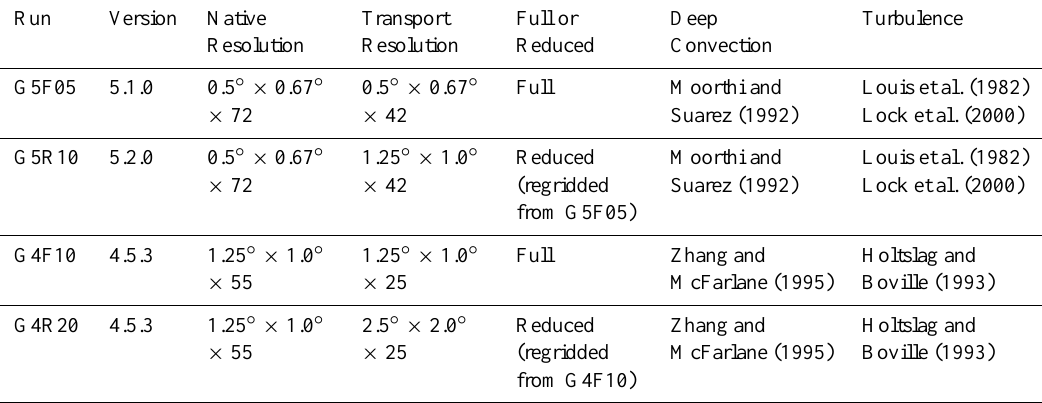
Table 1. Description of meteorological datasets used in offline tracer transport simulations. Column 1 (Data) is the code name for the meteorological dataset, 2 (Version) is the version of the analysis product, 3 (Native Resolution) is the resolution at which the analysis system (forecast + assimilation) is run ( a × b × c = latitude spacing × longitude spacing × number of vertical levels), 4 (Transport Resolution) is the grid spacing at which the analysis is saved, 5 (Full or Reduced) refers to whether the analysis is saved at the native resolution of the parent GCM or interpolated to a coarser resolution, 6 (Deep Convection) is the deep convection scheme of the parent GCM, and 7 (Turbulence) is the PBL turbulence scheme of the parent GCM. Naming convention for analysis product in the first column is as follows: character 1–2 is the product version number (G4 = GEOS-4 and G5 = GEOS-5), character 3 is the grid at which the analysis is saved (F = full resolution and R = reduced resolution), and character 4–5 is the latitude grid spacing at which the analysis is saved for offline transport (05 = 0.5 ◦ , 10 = 1.0 ◦ , 20 = 2.0 ◦